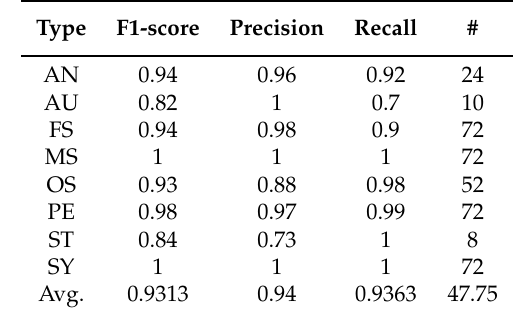
Table 10. NAS model 2 (the augmented data).